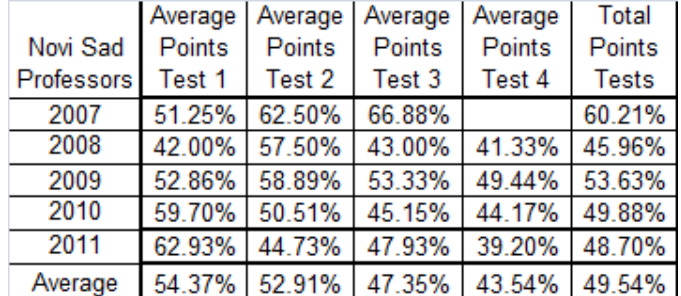
Test Points for Novi Sad Students of Geography and